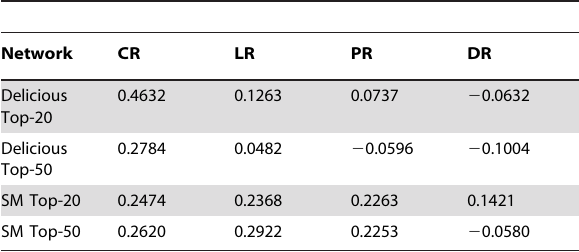
Table 4. Kendall’s tau between ranking scores provided by different methods and the real spreading abilities.